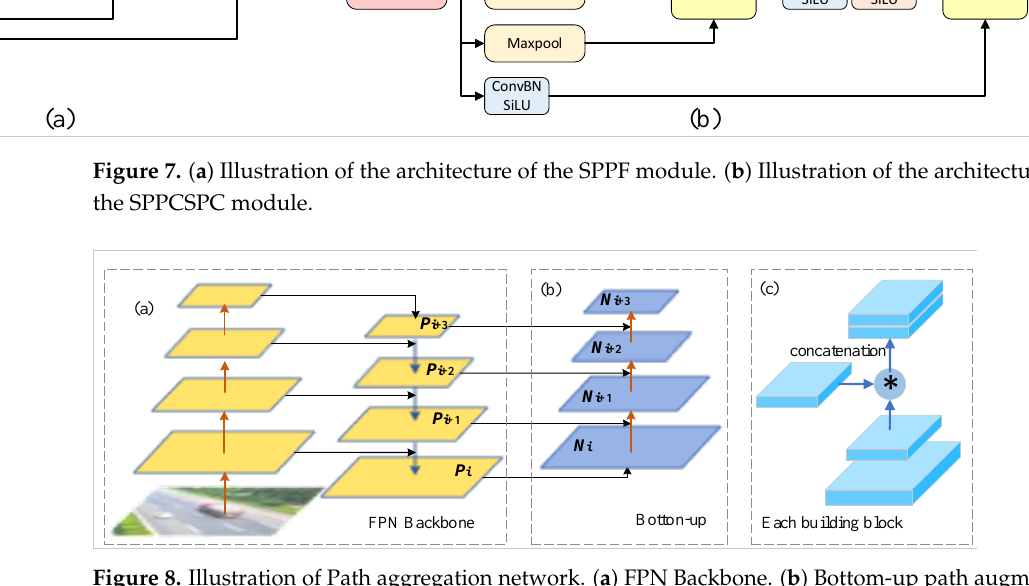
Figure 8. Illustration of Path aggregation network. ( a ) FPN Backbone. ( b ) Bottom-up path augmenta- tion. ( c ) Each building block.